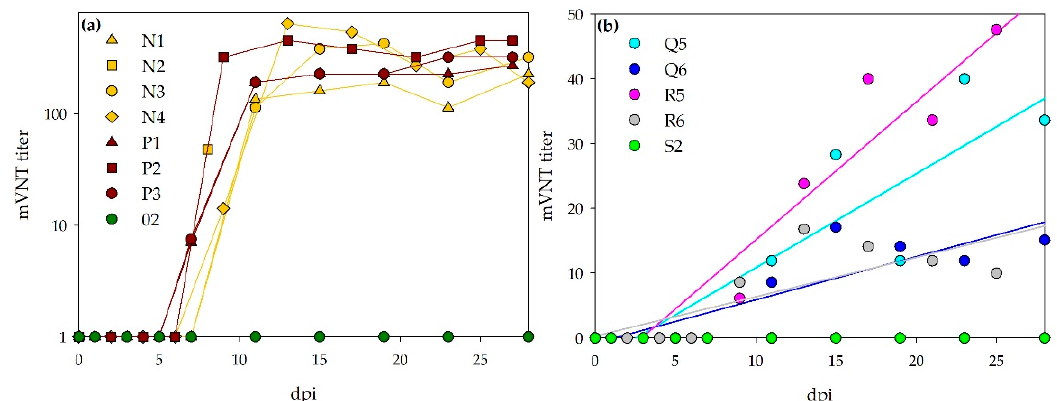
Figure 9. Course of mVNT titers: Panel ( a ) visualizes the rapid increase in mVNT titers for the infected sheep. Panel ( b ) shows the steady increase (linear regression, calculated by SigmaPlot) of mVNT titers for the inoculated calves. Attention has to be paid on the different axis scaling for bovines and ovines.